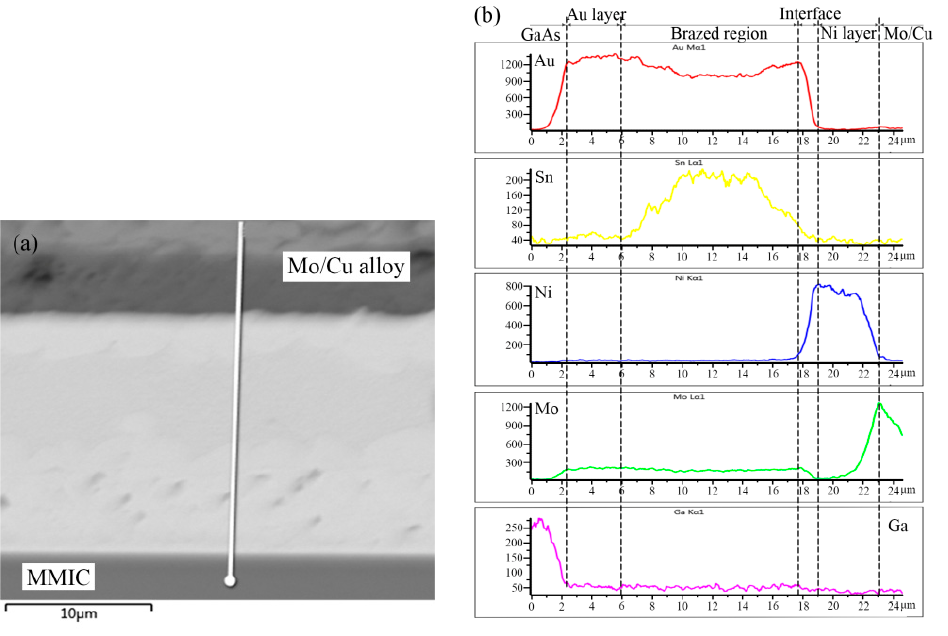
Figure 5. EDS analysis of TiW / Au | Au-Sn eutectic joint: ( a ) measured position and ( b ) elemental